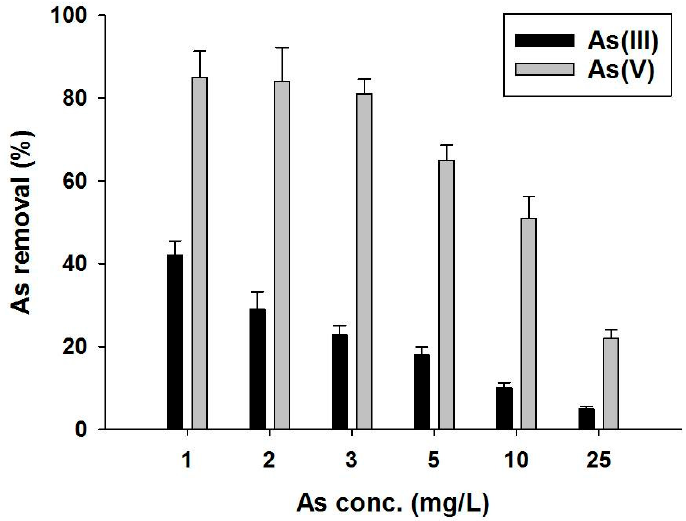
Figure 2. Percent change in live mycelial biomass of Talaromyces sp. KM-31 at various initial arsenic concentrations (1.0~25.0 mg/L) in an arsenic removal assay. The experimental conditions were biomass 60 g/L, contact time 72 h, pH 6.0, temperature 30 °C, and shaking at 160 rpm.